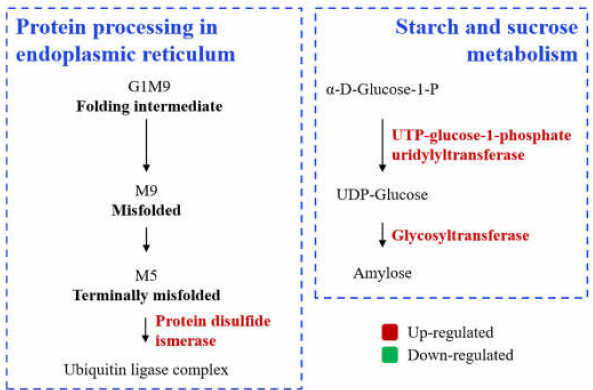
Figure 5. Storage drives alterations of metabolic pathways in Jianzhen 2 (indica